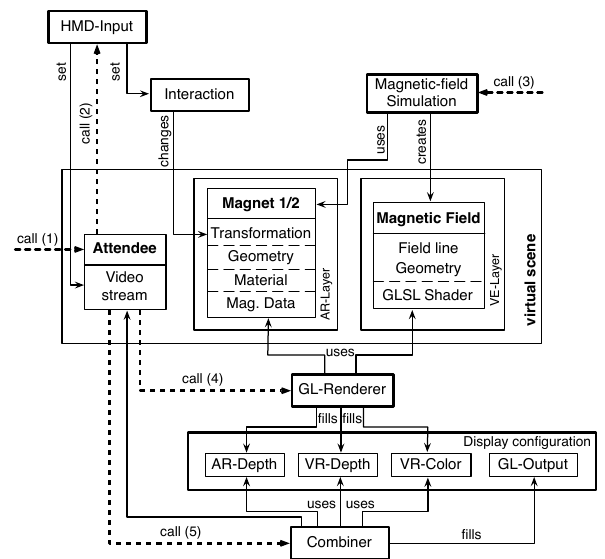
Fig. 6. Work-flow of the application using the AR setup. Dotted lines indicate system calls and the solid lines show the internal ”calls” beetween the used plug-ins and the virtual scene. Plug-ins are drawn with thick border. All attributes (Video stream, Geometry, ...) are also part of one or more plug-